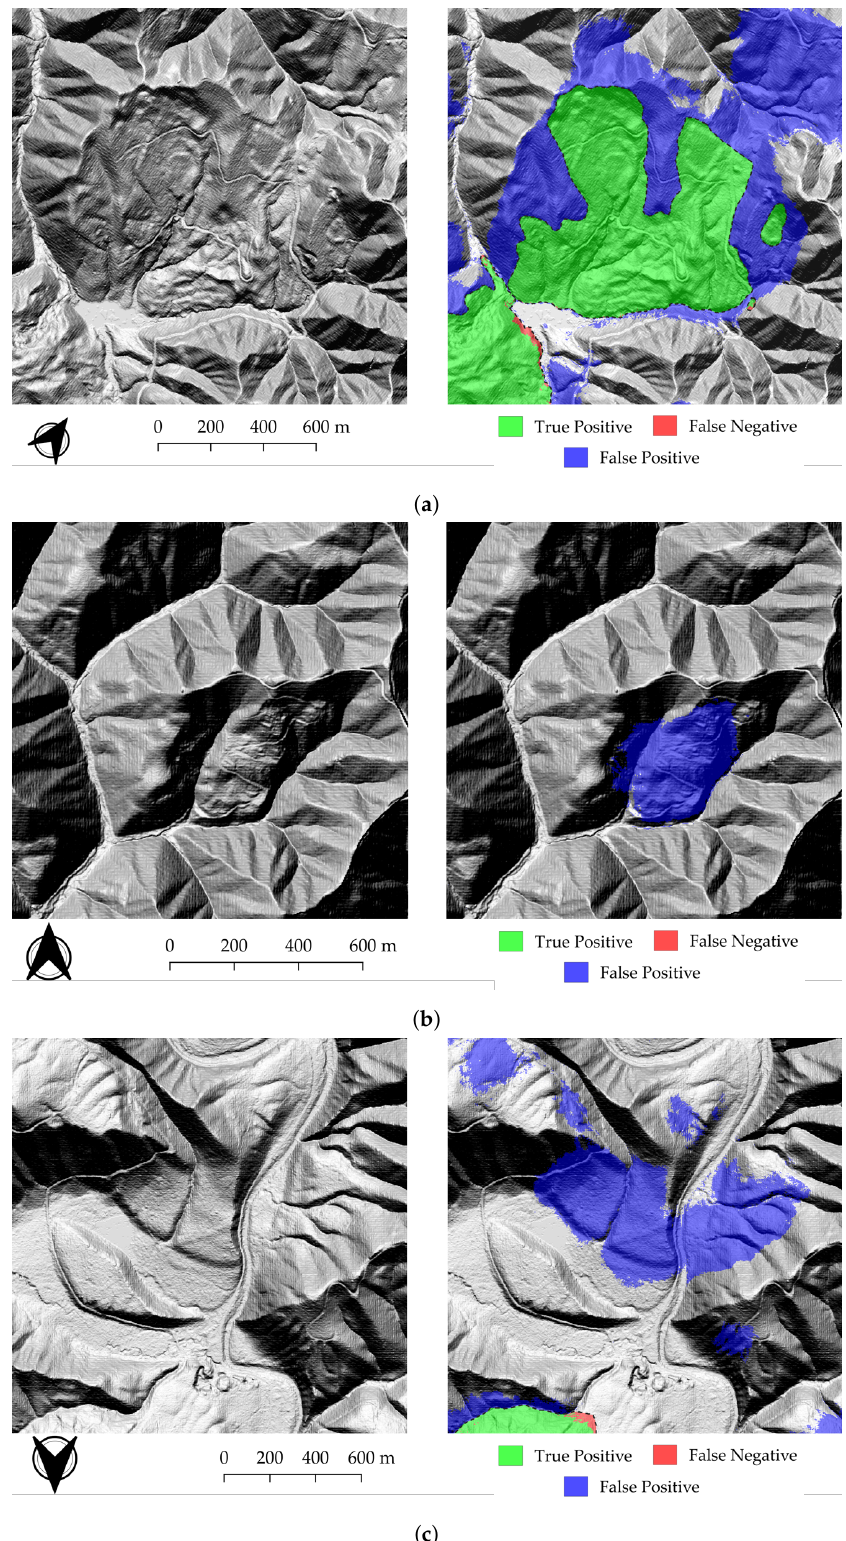
Figure 10. Closer look on false positives of deep-learning method. The hillshade of TP and FP detected slopes are on the left with the corresponding confusion matrix values as colored overlays on the right. ( a ) Mismatch in the boundaries of predicted landslide and SLIDO inventory. ( b ) Possible missing information. ( c ) Wrong detection. All the maps are in UTM Zone 10N with WGS 84 datum